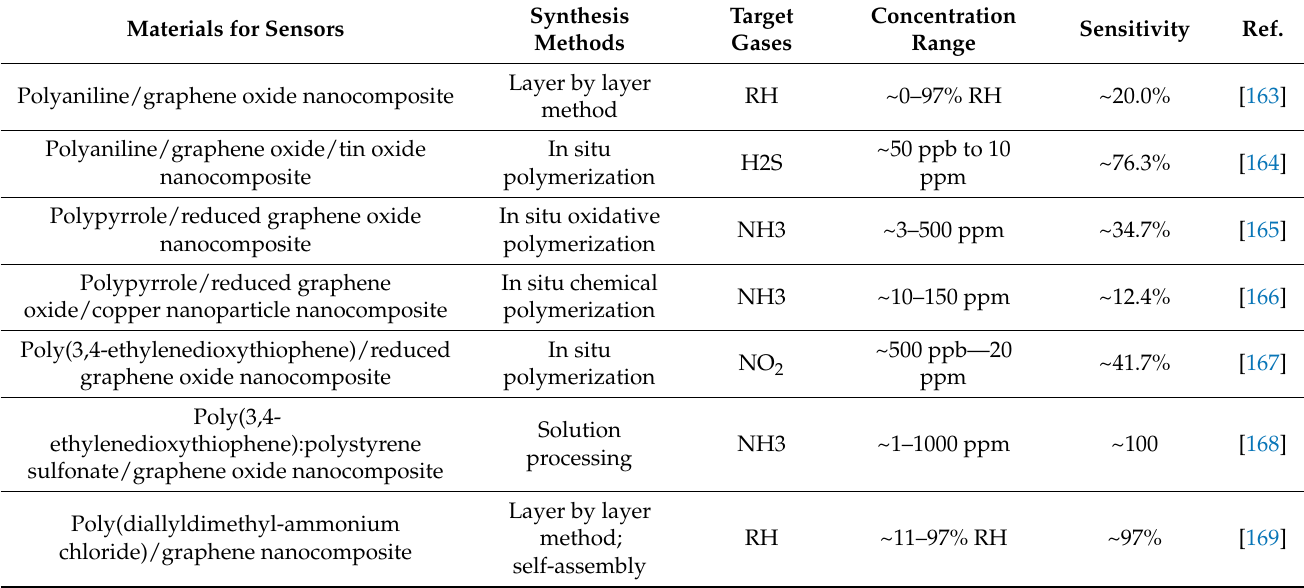
Table 2. Gas sensors based on polymer/graphene oxide nanocomposites with polymeric materials.